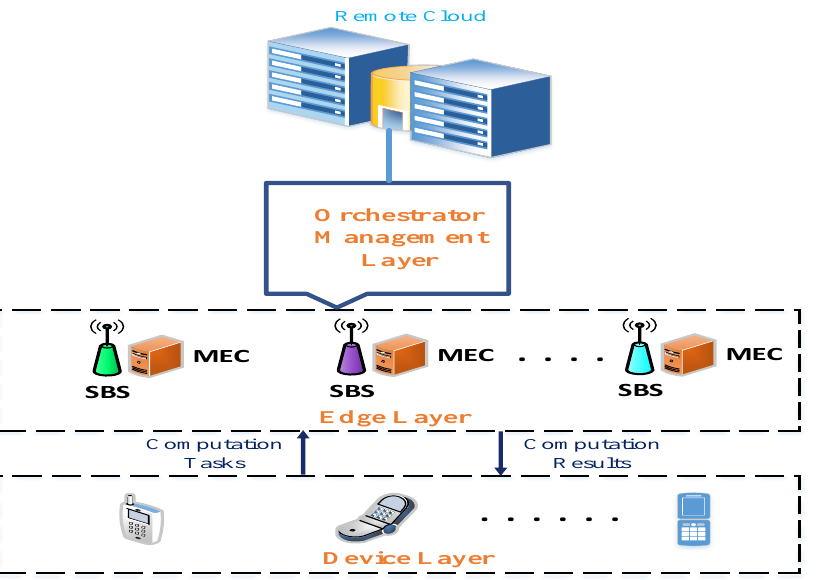
Figure 3. Orchestrator management